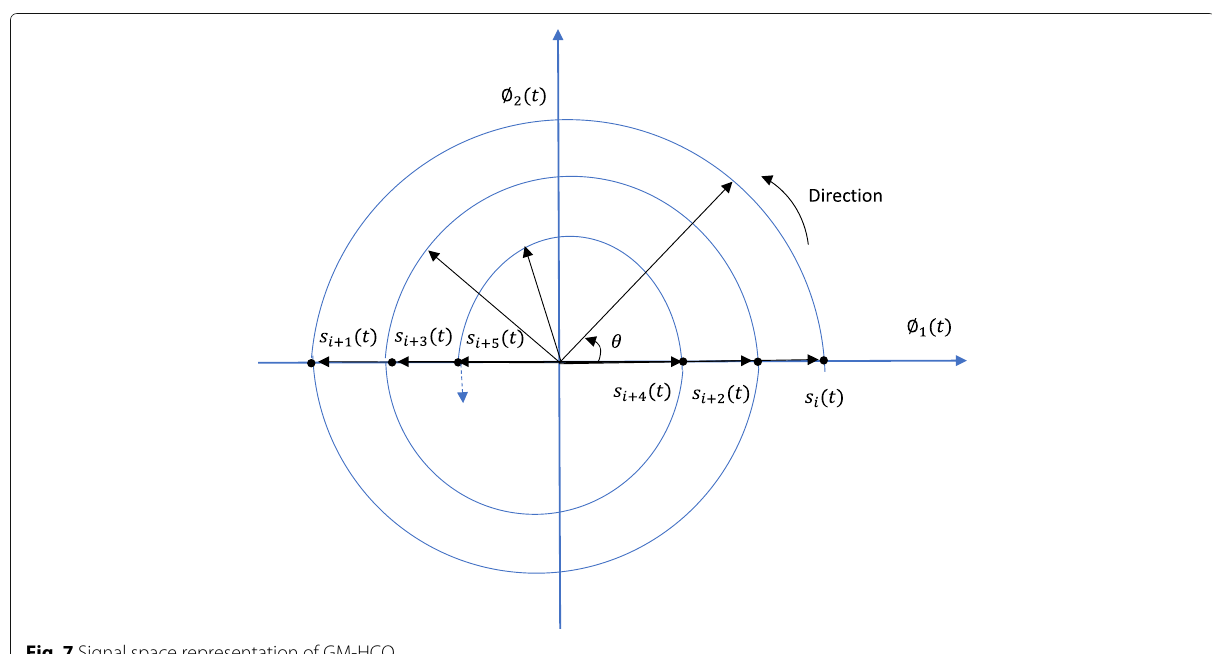
Fig. 7 Signal space representation of GM-HCO